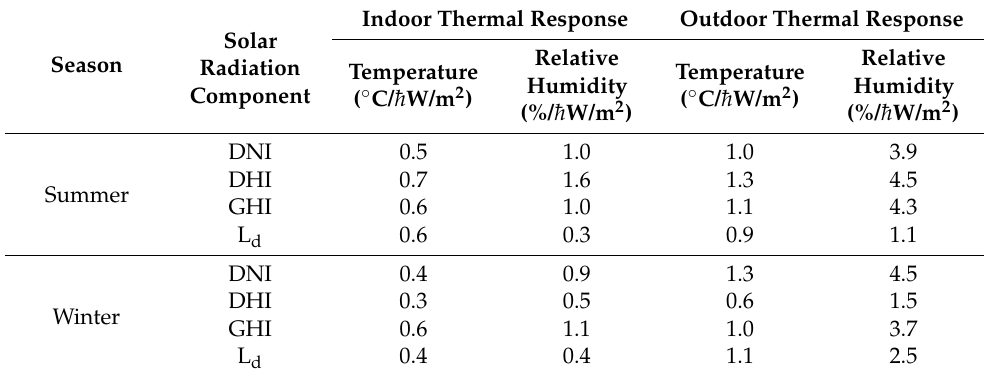
Table 3. Thermal response of the passive solar building to solar radiation